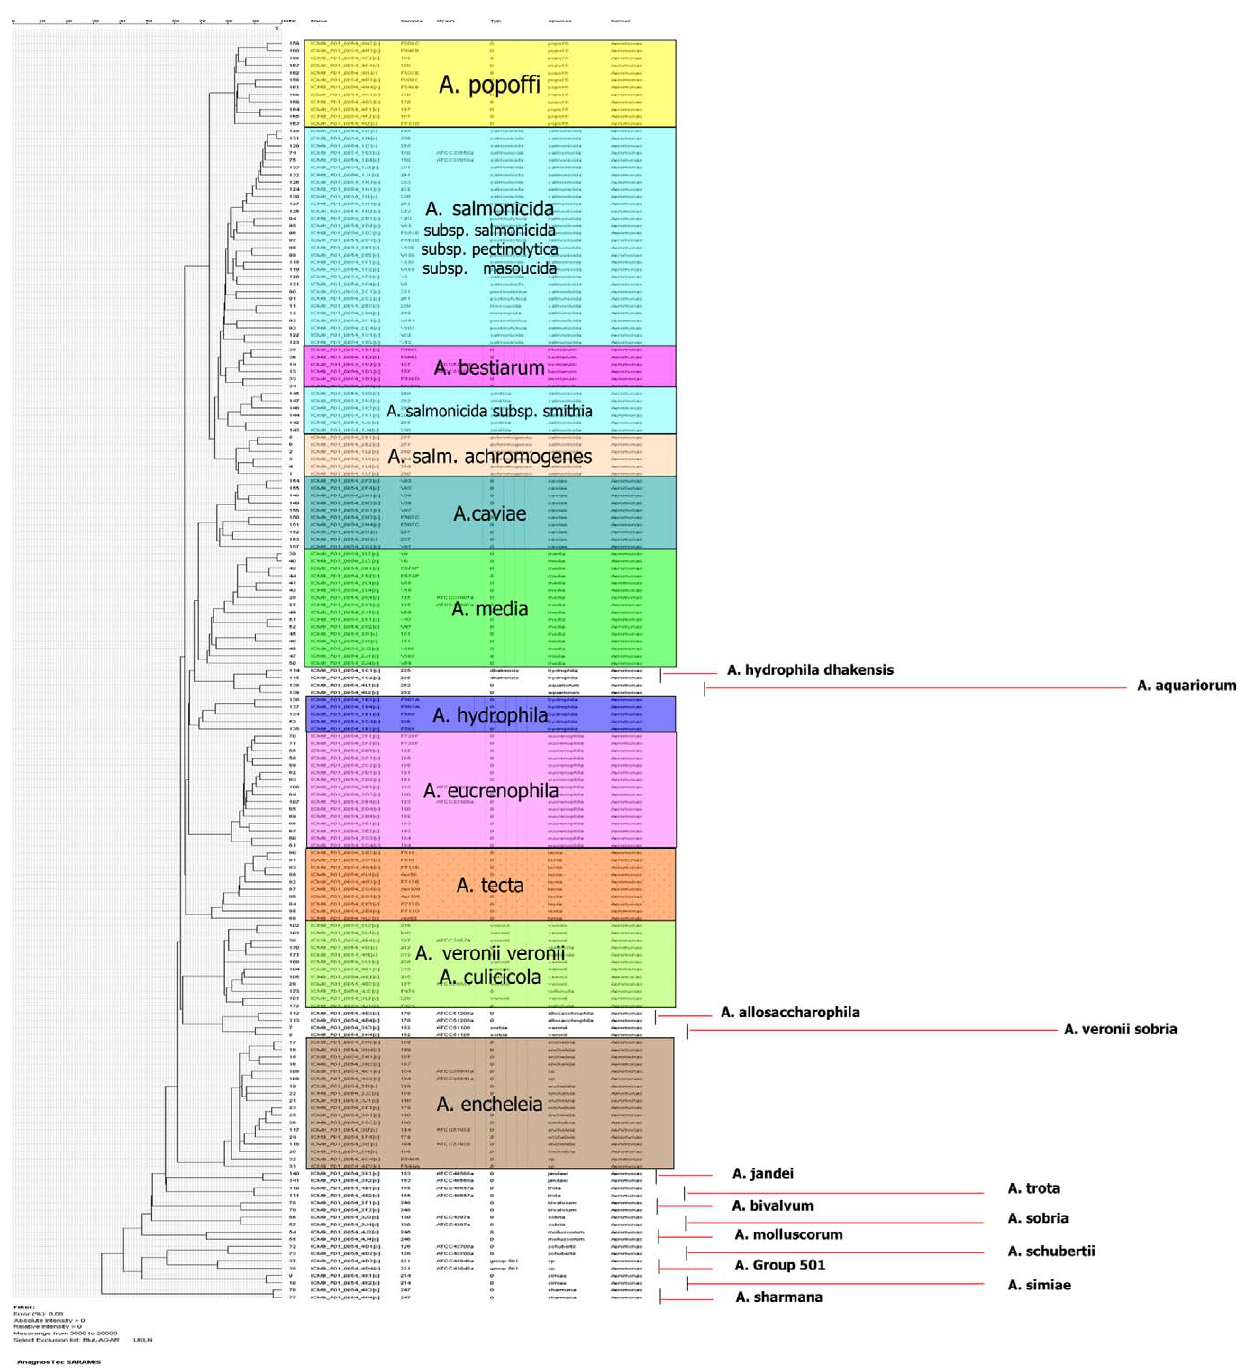
Figure 1. Dendrogram resulting from single-linkage cluster analysis of MALDI-TOF mass spectra. Error 0.08%; Mass range from m/z 2,000 to